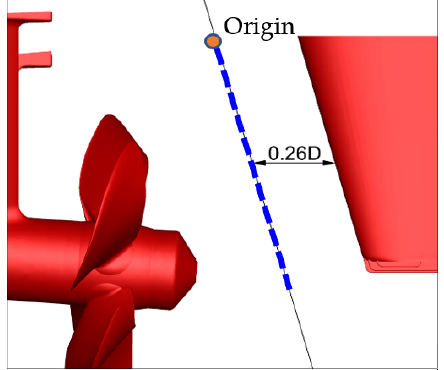
Figure 16. Traversing position for measurement.